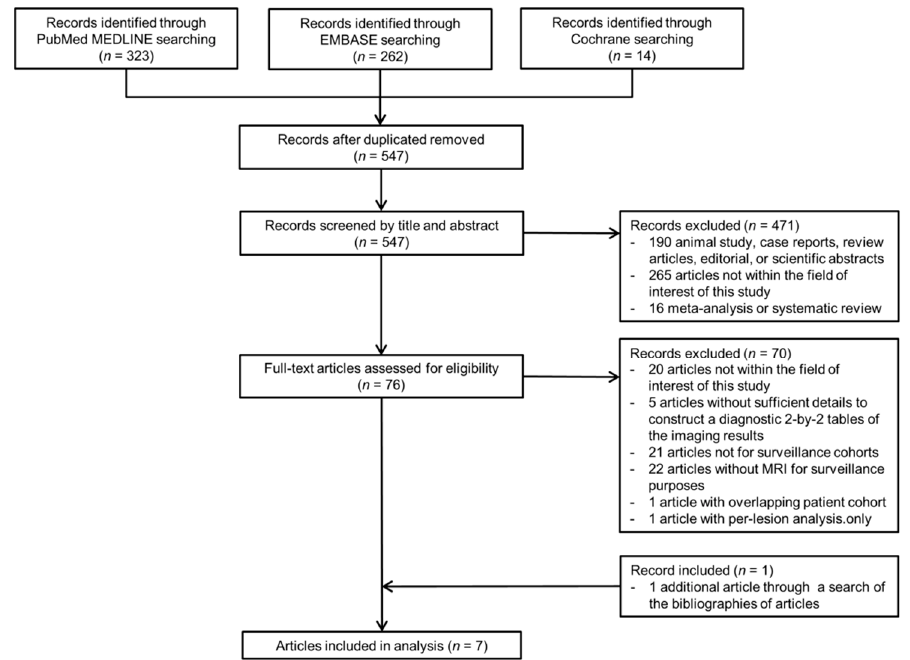
Figure 1. PRISMA flow diagram.